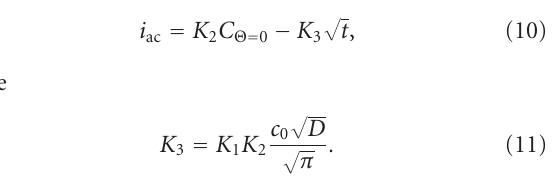
With higher concentrations of surfactants it might be more favourable to measure under di ff usion conditions.